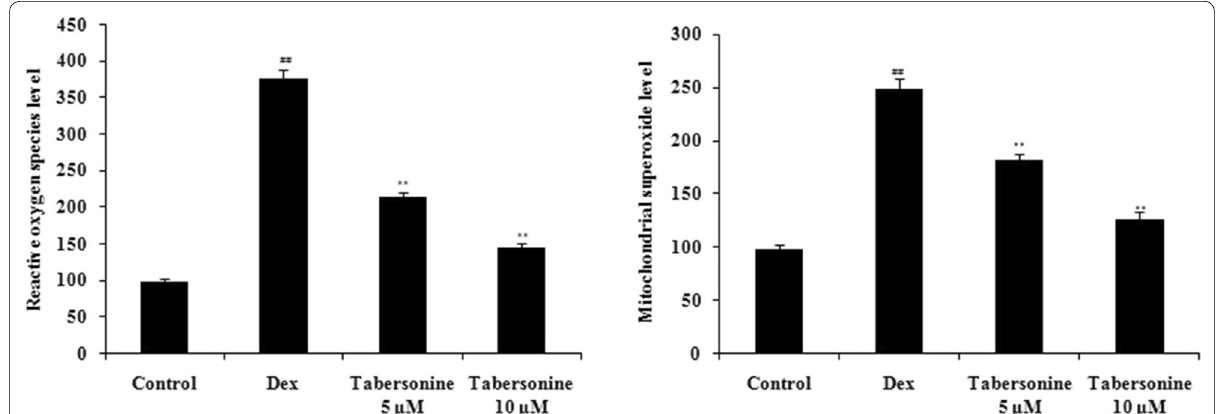
Fig. 3 Effect of tabersonine on mitochondrial superoxide and reactive oxygen species production in osteoblasts, measured via flow cytometry. Means